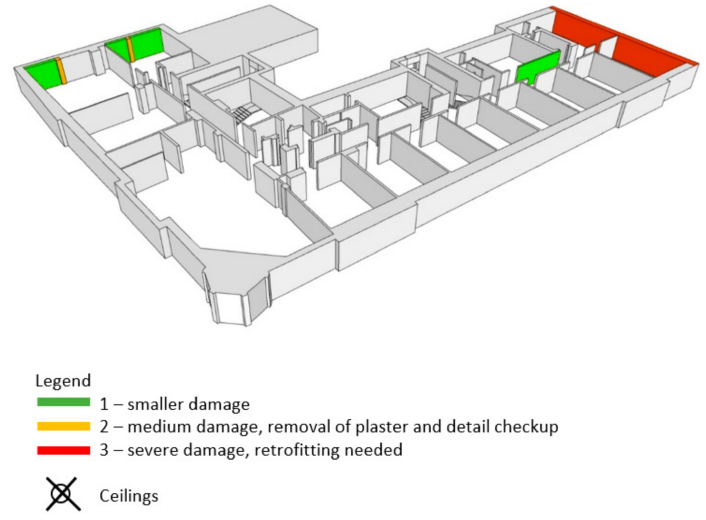
Figure 12. Damage scheme for the 3rd floor of the building.